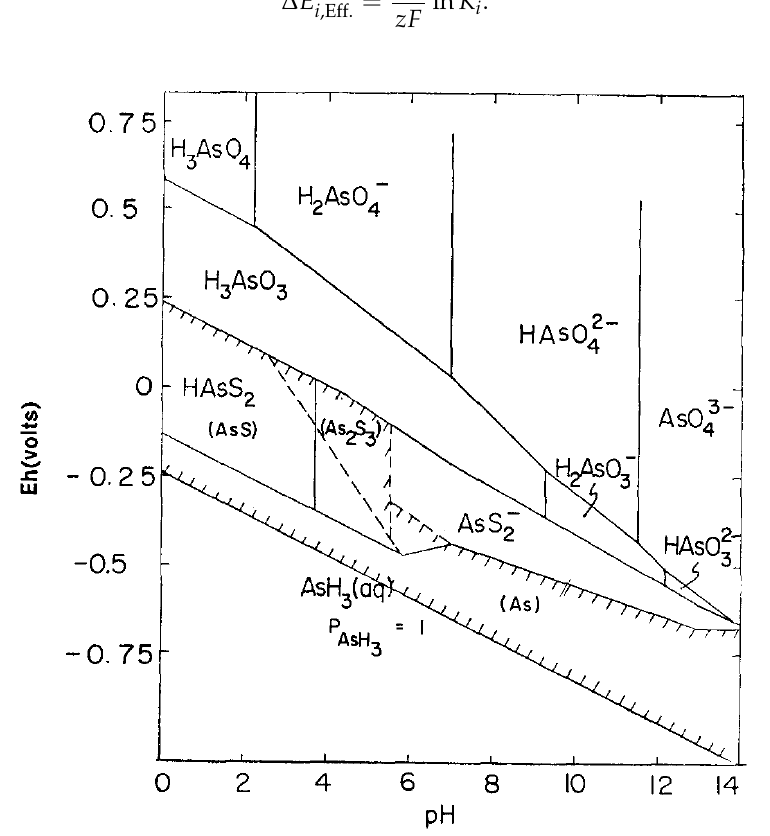
FIG. 1. The Eh-pH diagram for As at 25°C and one atmosphere with total arsenic 10- 5 mol 1- Figure 4. The Eh -pH diagram for As at 25 ◦ C and one atmosphere with total arsenic 1 × 10 − 5 molL − 1 . and total sulfur 10 -3 tool 1-1. Solid species are enclosed in parentheses in cross-hatched area, Reprinted from [23], with permission from which indicates solubility less than 10 -5.3 tool 1-t.